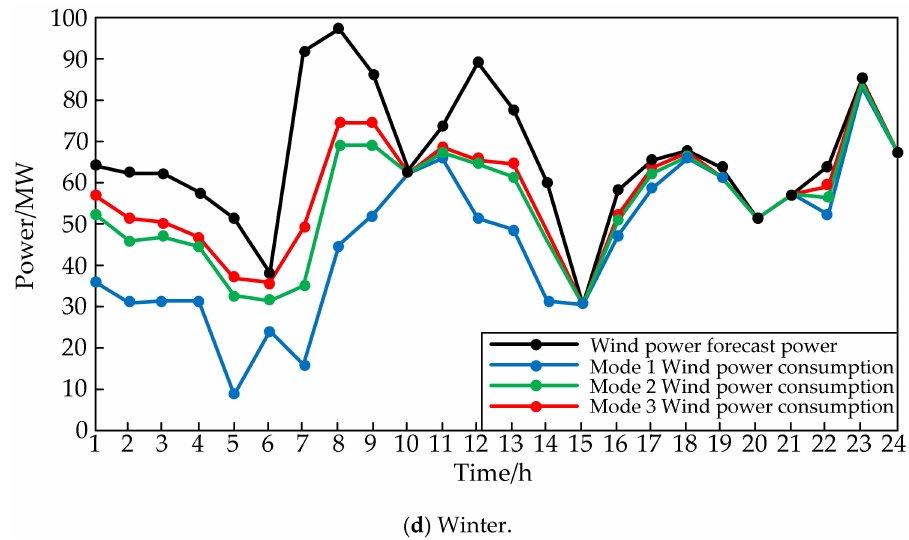
Figure 8. Wind power forecasting power and consumption power. Table 7. Unit commitment results.